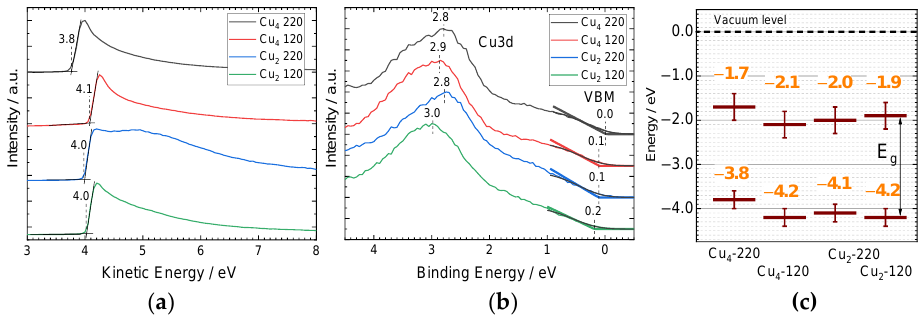
Figure 3. The secondary electron cut-off (SECO) ( a ) and valence band (VB) ( b ) XPS spectra of the initial and annealed CZTS NC films with the nominal contents Cu 2 and Cu 4 . ( c ) Energy level diagrams derived from the XPS and optical spectroscopy data.